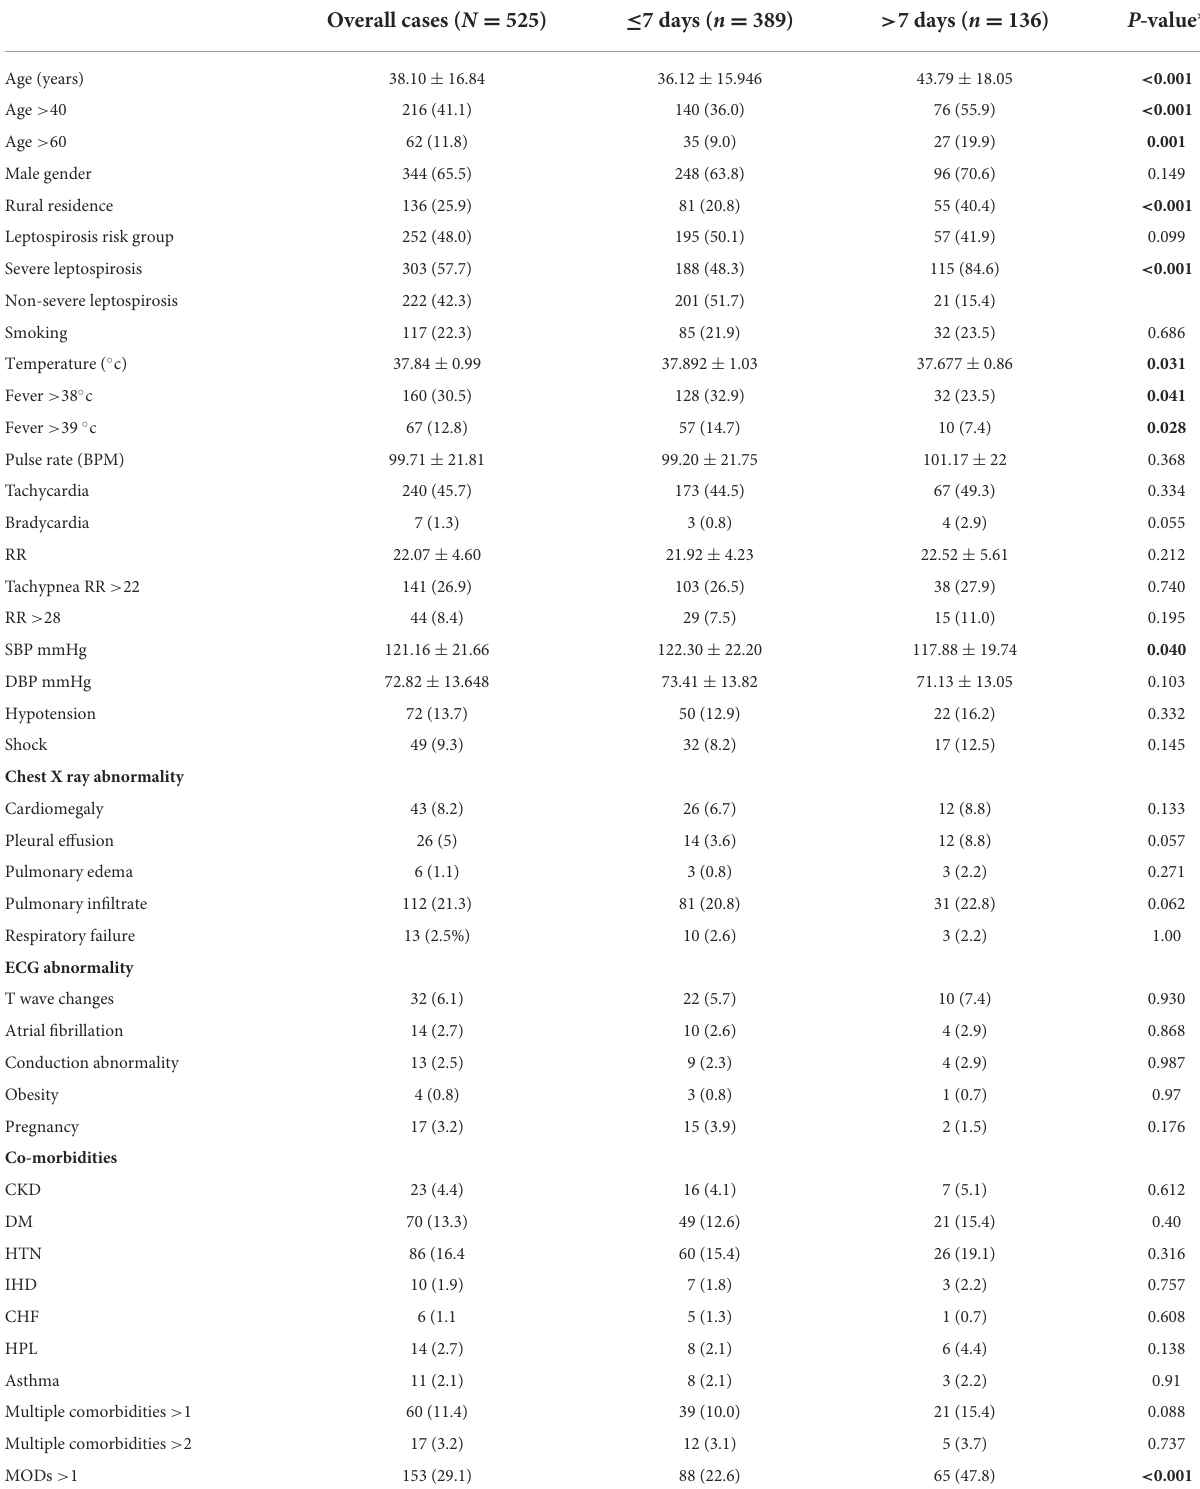
TABLE 1 Comparison of demographics and clinical features (at baseline) between patients with and without prolonged hospitalization ( > 7